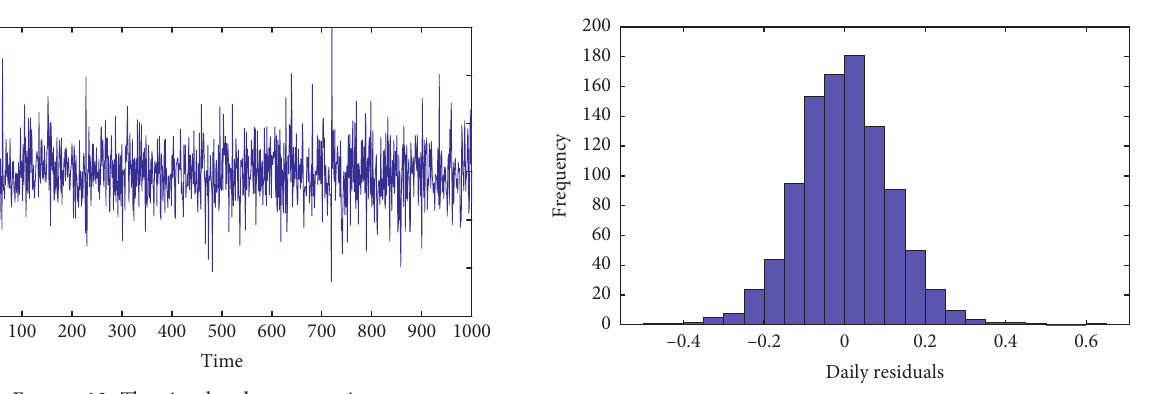
Figure 16: The histogram of simulated residual series. Table 9: The EGARCH-ANN (2, 4, 0, 0) model fitted to the given data.